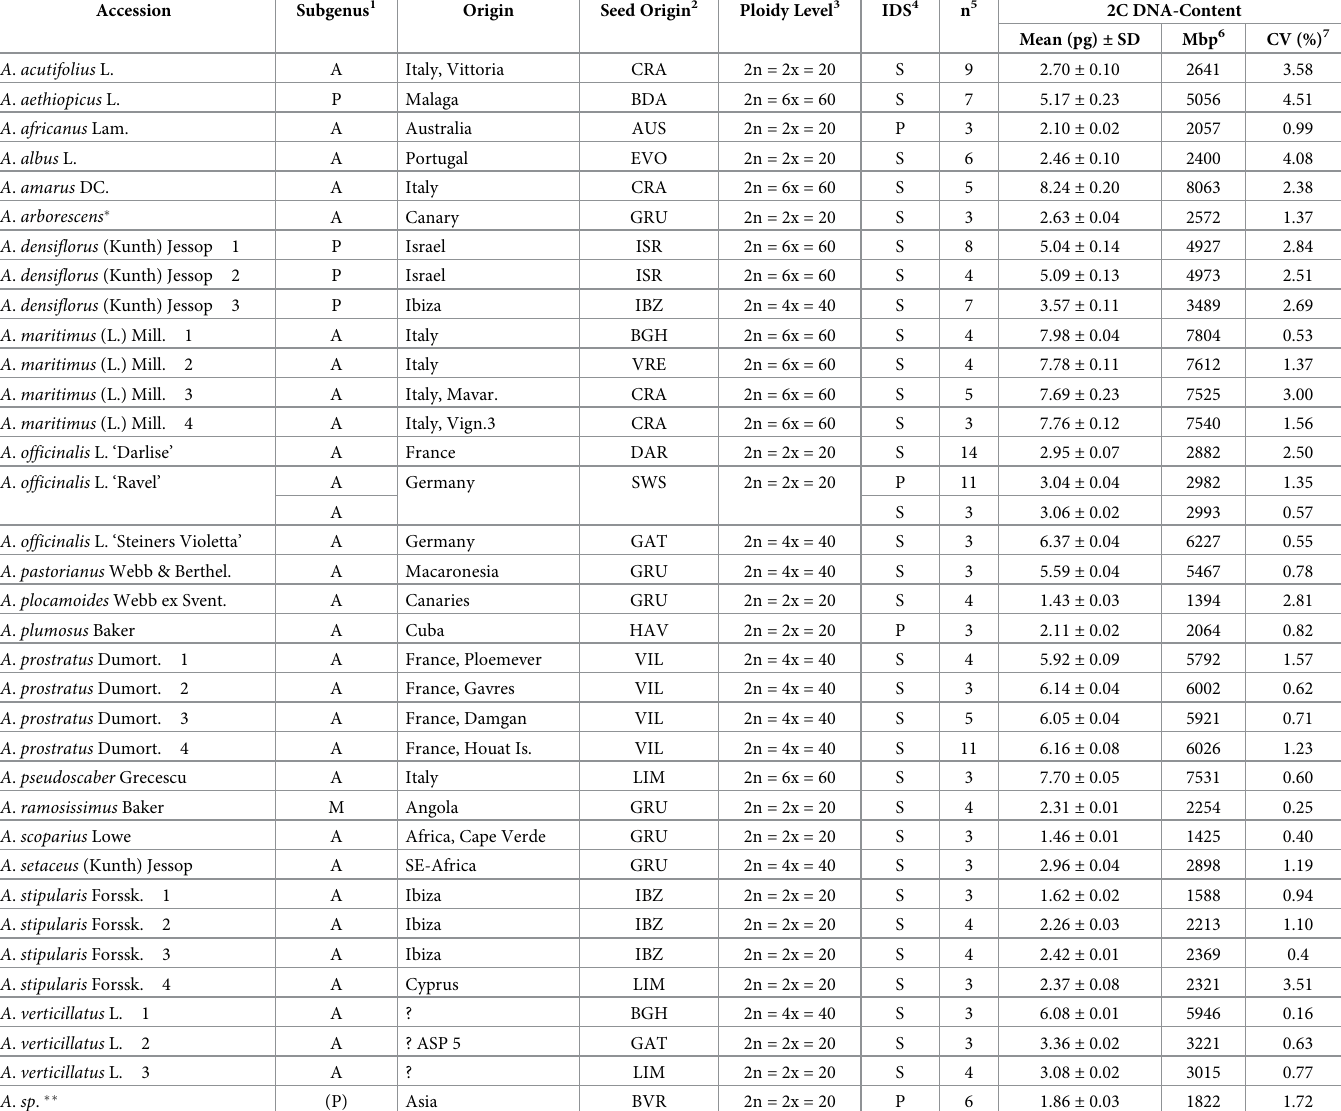
Table 1. Asparagus accessions used for the study, their ploidy level and the estimated average genome size (2C DNA content).